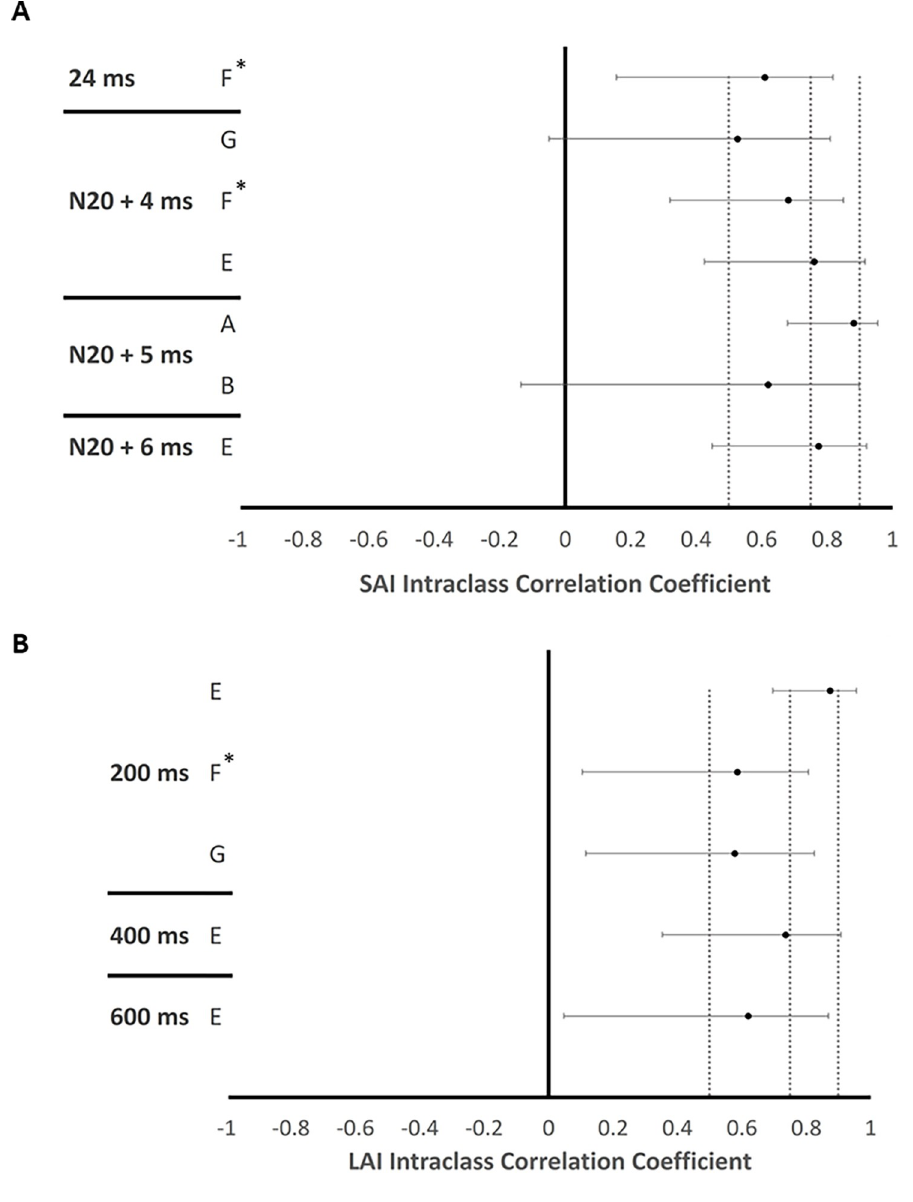
Fig 7. Reliability according to ISI. Panel A and B shows the reliability of measurements performed at each ISI for SAI and LAI, respectively. ICC values with 95% confidence intervals are shown for each ISI tested in the studies that comprise dataset 2. Vertical dashed lines reflect the border between low, moderate, strong, and excellent reliability, from left to right. � Indicates a that the ICC and 95% confidence interval for Study F are referenced from Turco et al., [14]. A = Tsang et al. 2014; B = Tsang et al. 2015; C = Bailey et al. 2016; D = Turco et al. 2017; E = Turco et al. 2018; F = Turco et al. 2019; G = Toepp et al. 2019. H = Harasym et al. 2020. This suggests that in a healthy control population, SAI and LAI are not expected in all partici- pants. This challenges the inclusion of the term “inhibition” when labelling these measure- ments. Importantly, labelling the measurement as long- or short-latency afferent “ inhibition ” may influence decisions to include or exclude data and arbitrarily identify individuals as non-